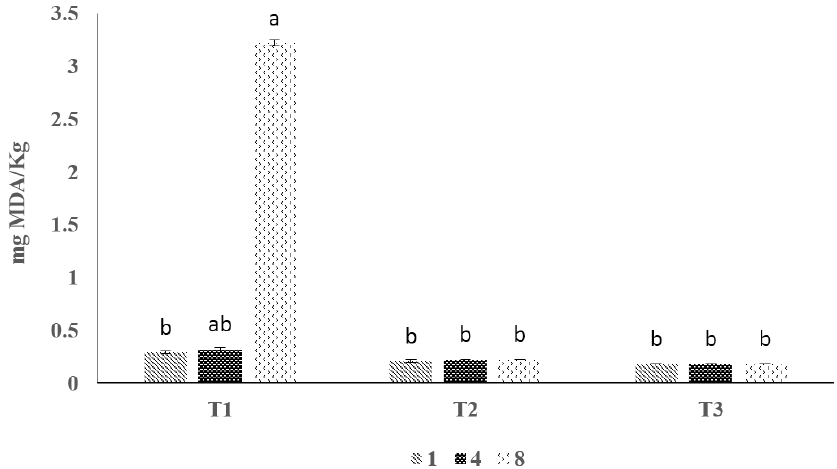
Figure 3. The effect of surimi-based coating on TBARS of shrimp during storage at 4 ± 1 ◦ C. Data are given as mean values ± standard deviation ( n = 3). Different letters on the top of data bars indicate significant differences (Tukey’s test, p < 0.05) between mean values. T1, control; T2 surimi-based coating without MMT; T3, surimi-based coating with MMT.